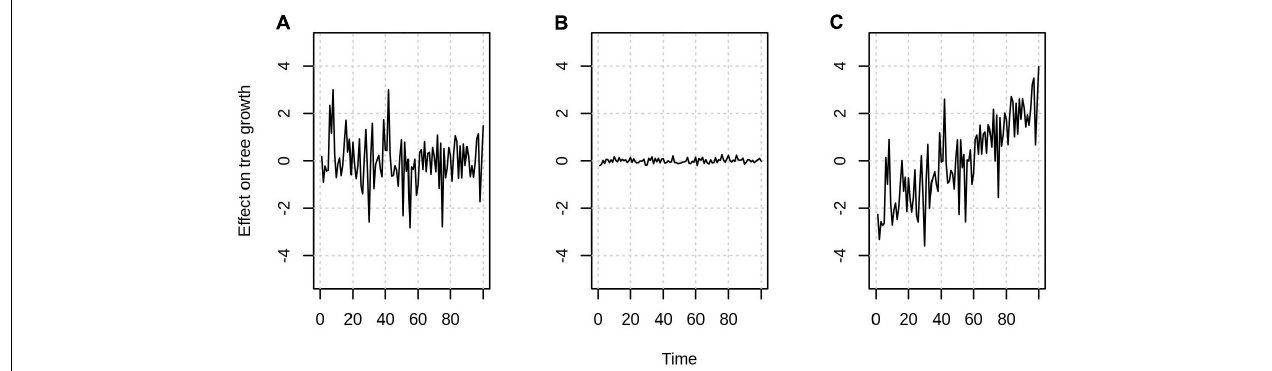
FIGURE 2 | Variable’s effect on tree growth can either be (A) significant with no trend in time, (B) insignificant, (C) significant with a trend in time. Effects like in (C) always have to be accounted for when estimating growth trends. While effects like (A,B) might be